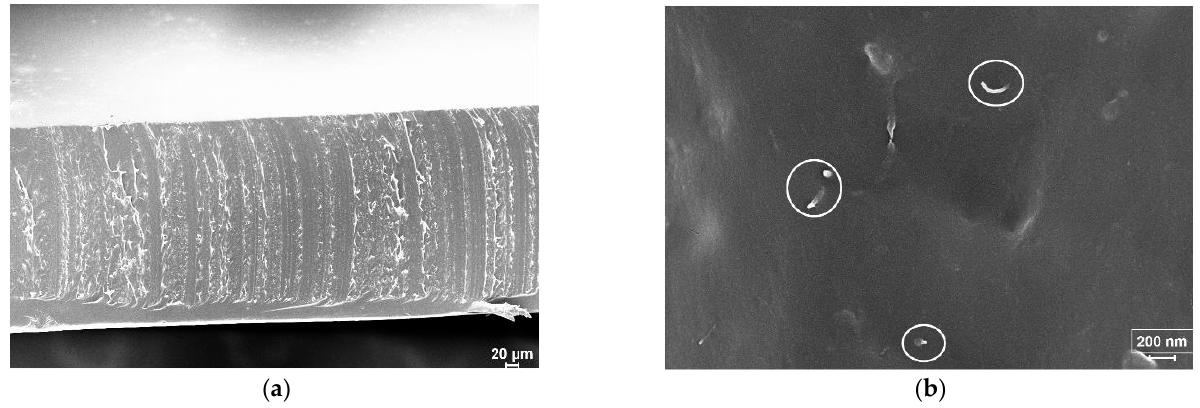
Figure 2. SEM analysis of the polyurea-polyurethane-MWCNTs nanocomposite films: ( a ) in cross-section; ( b ) from the top.